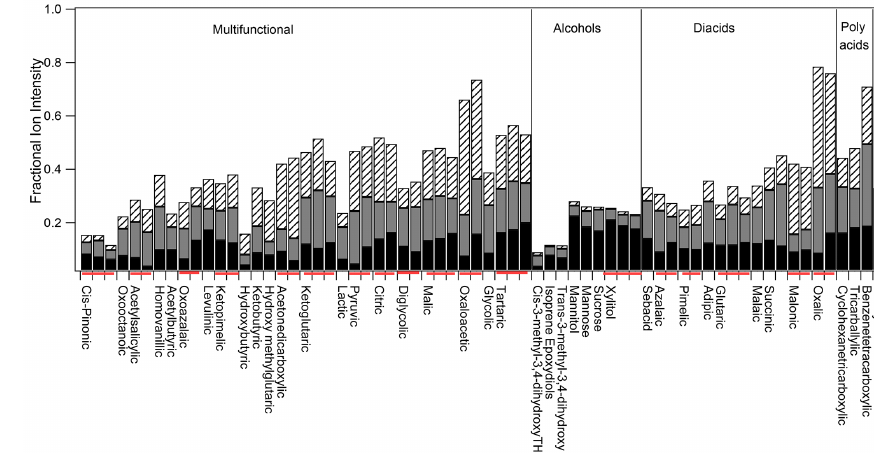
Figure 2. Fractional AMS ion intensities (relative to the total ion signal for each standard) measured for CO + each of the laboratory aerosol standards studied here. The standards are classified according to functionality and then arranged according to increasing O:C. Repeat measurements were performed for some of the standards to investigate the consistency of measured mass spectra between different HR-ToF-AMS instruments. Repeat measurements performed for the same standard are arranged together and denoted by red horizontal bars on the bottom axis of the graph.